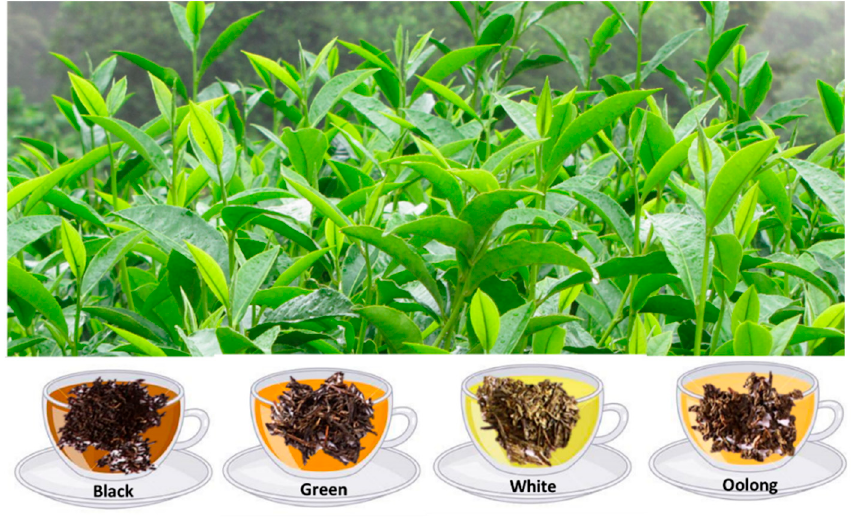
Figure 1. The Camellia sinensis plant and the different types of tea that can be produced from its leaves. Photo adapted from Forest & Kim Starr-Jardim Botânico UTAD, 2019 [6].